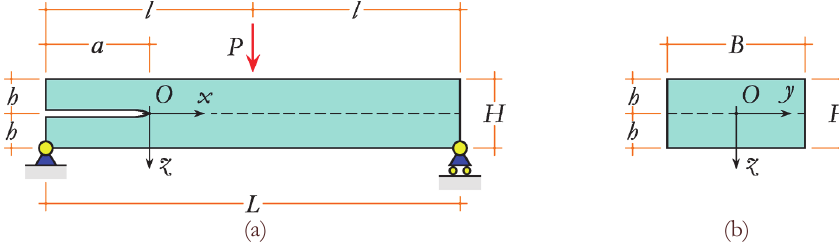
Figure 1: Scheme of the end-notched flexure (ENF) test: (a) side view; (b) cross section.